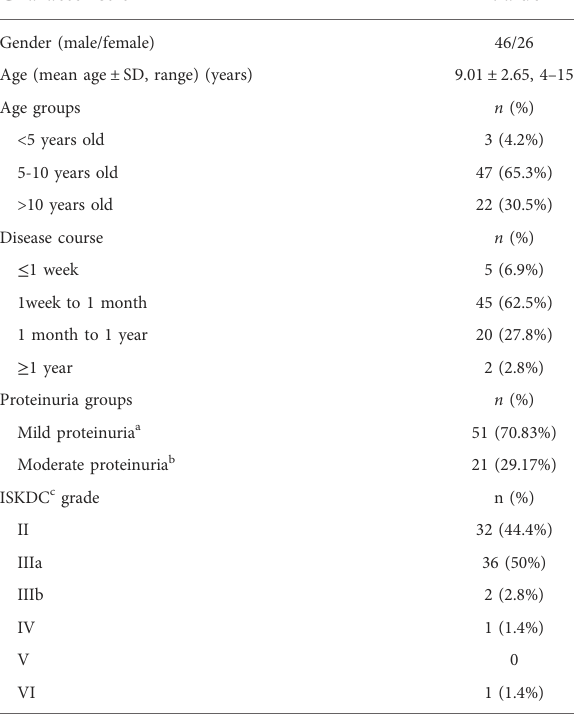
TABLE 1 The general data of patients.